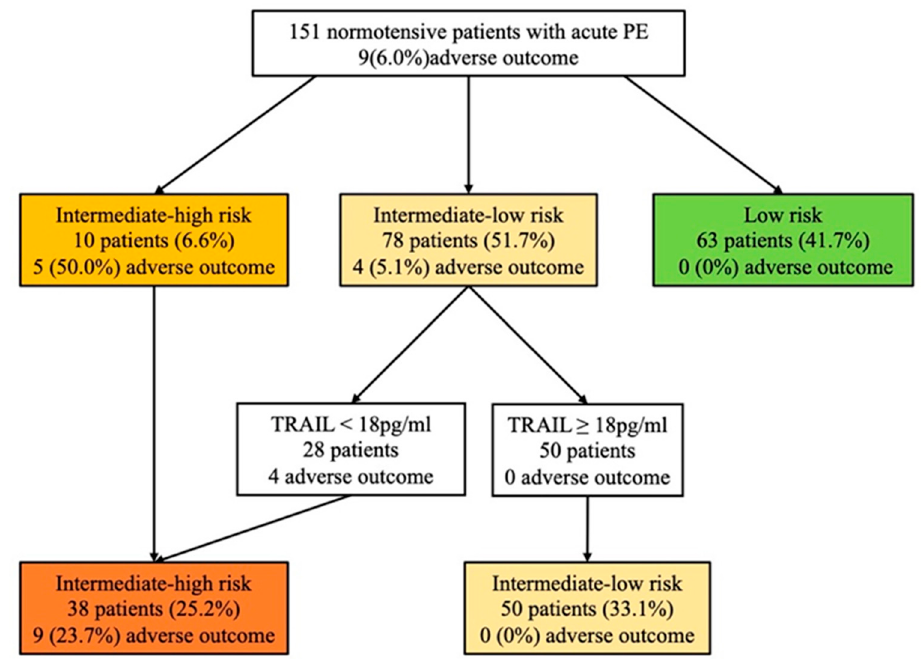
Figure 4. Risk assessment using the 2019 ESC algorithm and TRAIL. The number (%) of patients with an adverse 30-day outcome is shown for each strategy. Hs-cTnI levels > 0.04 ng/mL are defined as positive. PE: pulmonary embolism; TRAIL, tumor necrosis factor-related apoptosis-inducing lig- and.